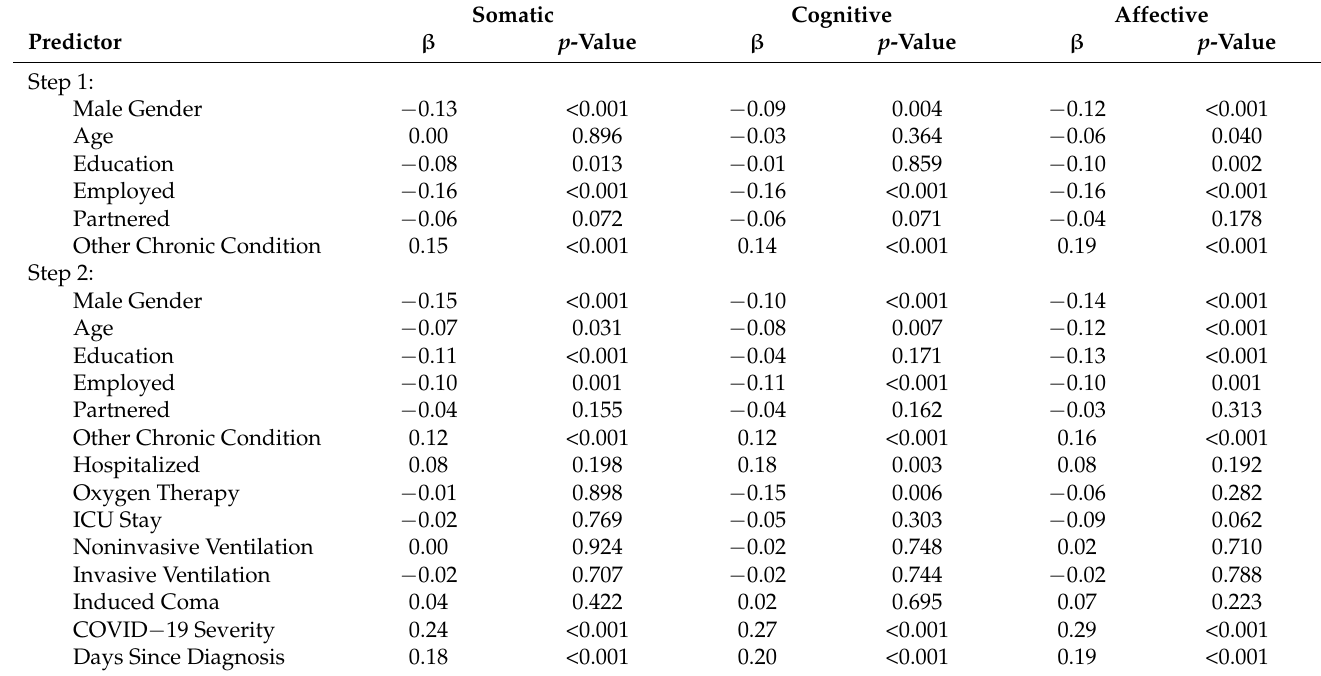
Table 3. Neurobehavioral symptom domain multiple regressions with standardized B-weights and p -value (N =